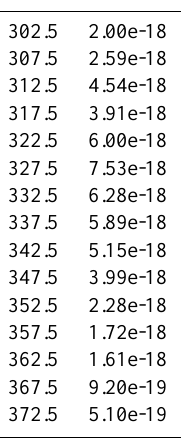
Table 3. As an example for a cross section data file, the con- tents of BrO_Cox(1982)_298K_300-375nm(5nm,int-c).txt is shown here. It belongs to the data set from Cox et al. (1982) shown in Table